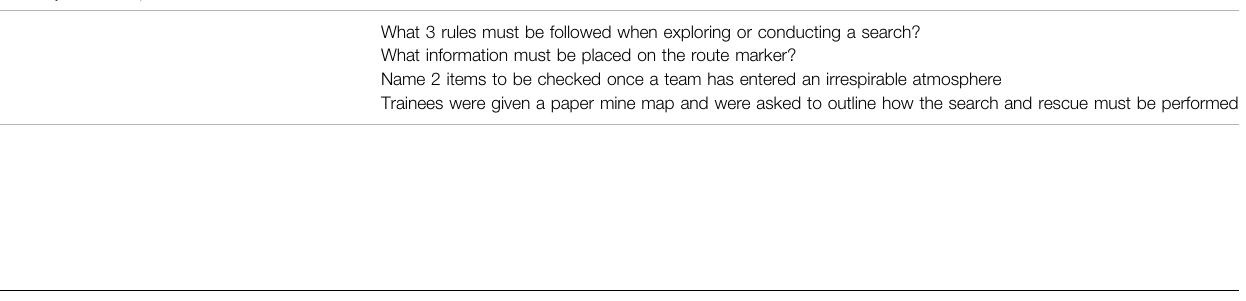
TABLE 4 | Pre-experience questionnaire.